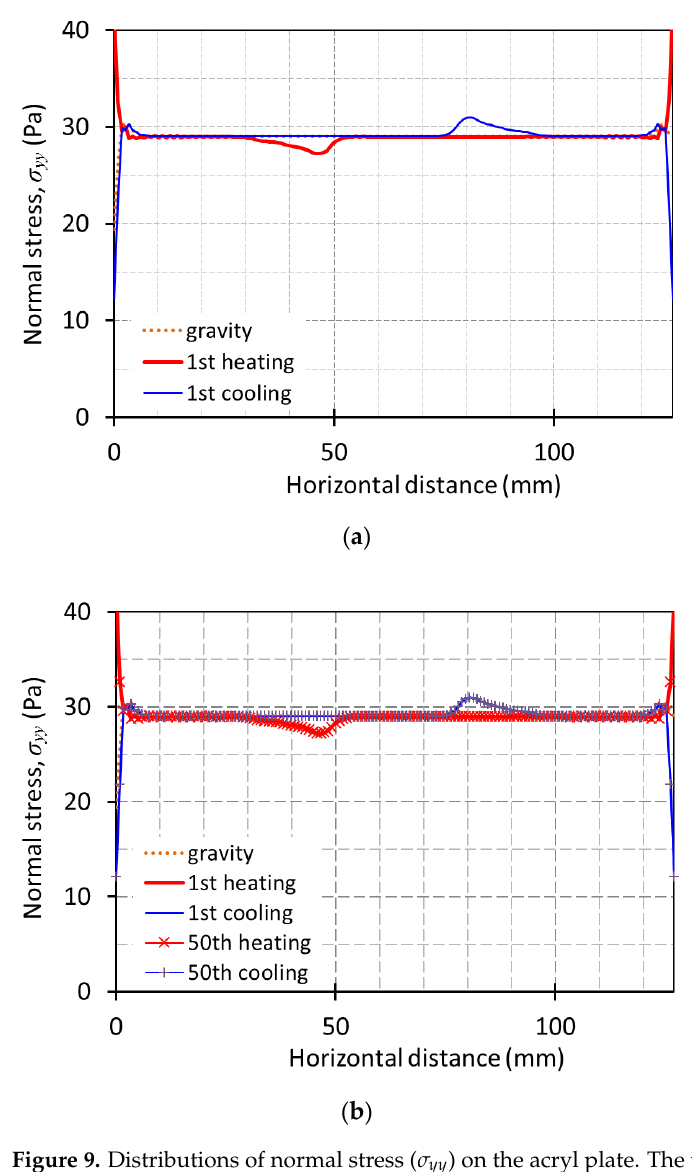
Figure 9. Distributions of normal stress ( 𝜎 𝑦𝑦 ) on the acryl plate. The presented results are based on ∆𝑇 = 23 ℃ in 𝛽 = 5° slope with the parameters in Table 1. ( a ) and ( b ) are the same as in Figure